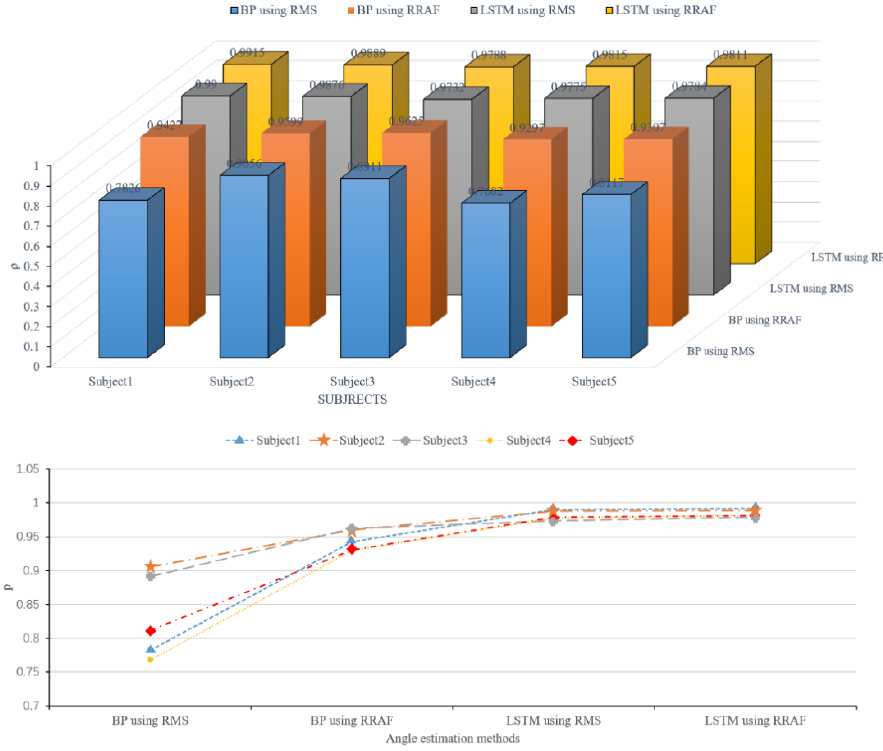
Figure 11. Comparison of the cross-correlation coe ffi cient ρ between the estimated angle and the real angle of knee joint obtain by the four methods (BPNN using RMS, BPNN using RRTAF, LSTM using RMS, LSTM using RRTAF) from subject 1 to subject 5.